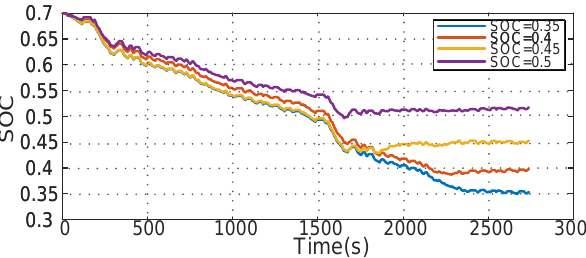
Figure 8. The SOC trajectories of different reference